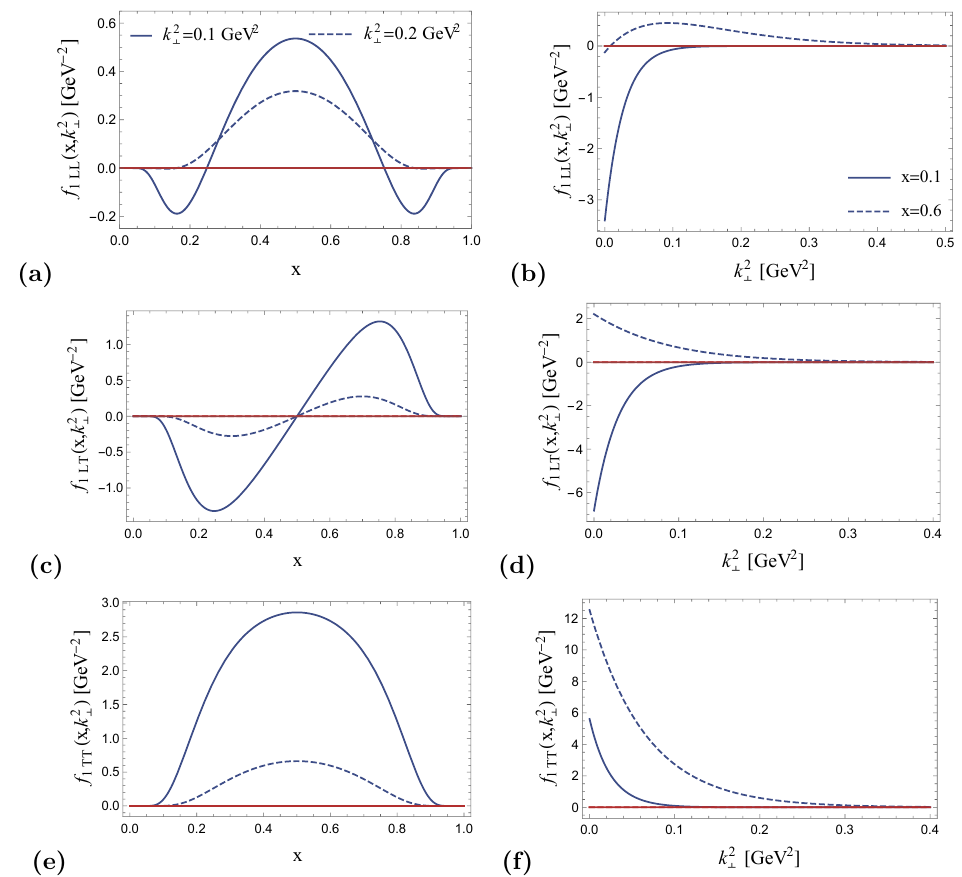
Figure 3 . (Color online) The tensor-polarized TMDs f 1 LL ( x, k 2 with respect to x at different value of k 2 k 2 = 0 . 2 GeV 2 (dashed curves). On the right panel, these TMDs are shown with respect to k 2 ⊥ at different values of x , i.e., x = 0 . 3 (solid curves) and x = 0 . 6 (dashed curves). The blue and red curves correspond to the light-front holographic model at the model scale µ 2 the light-front quark model predictions at the model scale µ 2